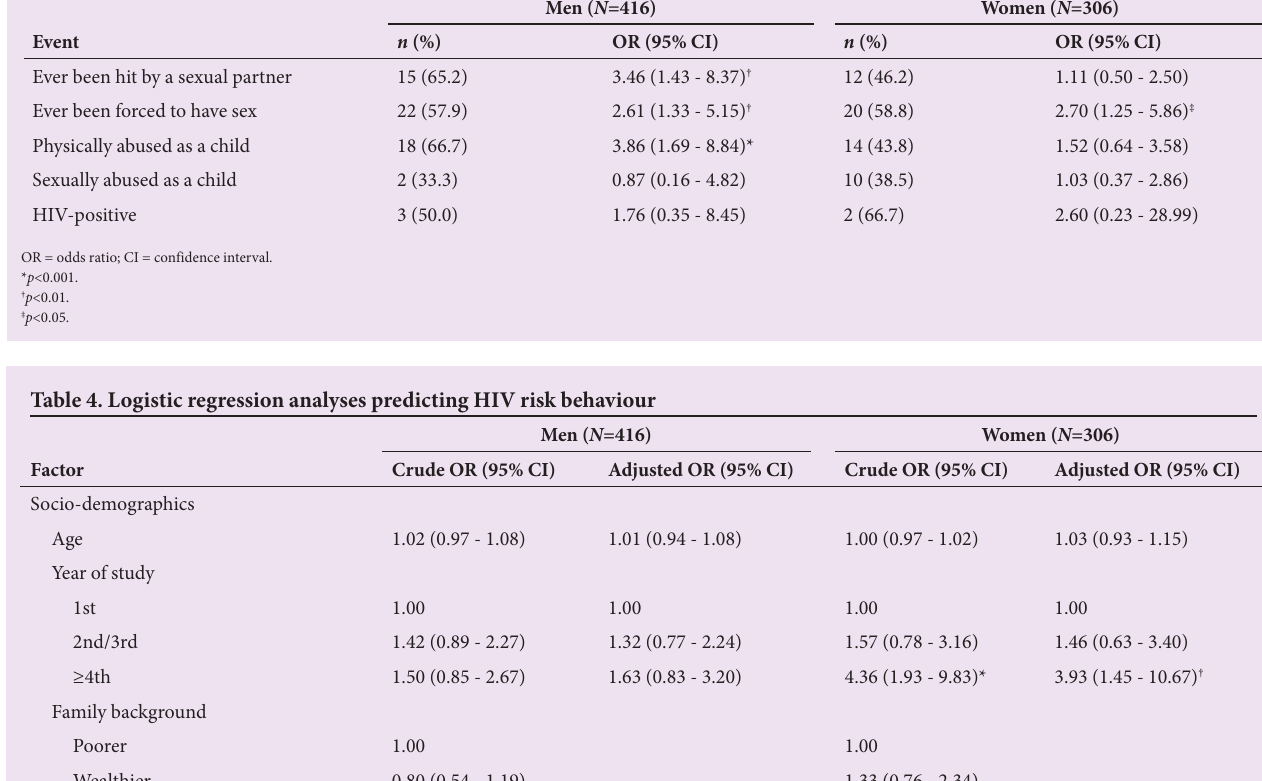
Poorer 1.00 1.00 0.80 (0.54 - 1.19) 1.33 (0.76 - 2.34)